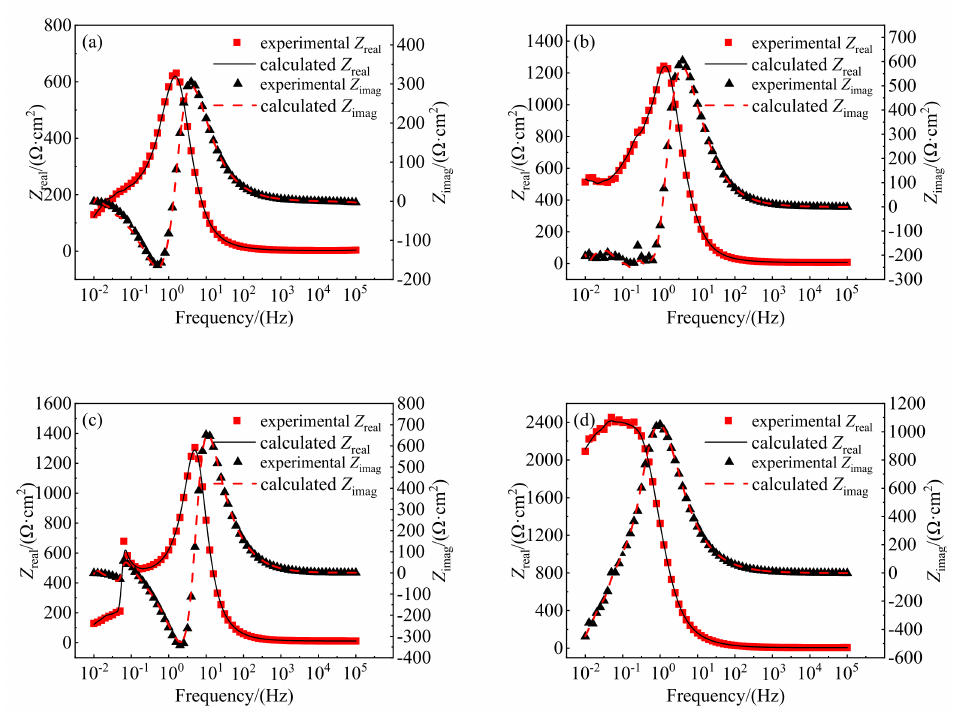
Figure 8. Typical Kramers–Kronig transforms of the real and imaginary components of the impedance of Al–5Zn–0.03In– x Er alloys in 3.5 wt.% NaCl solution: ( a ) Al–5Zn–0.03In; ( b ) Al–5Zn–0.03In–0.5Er;